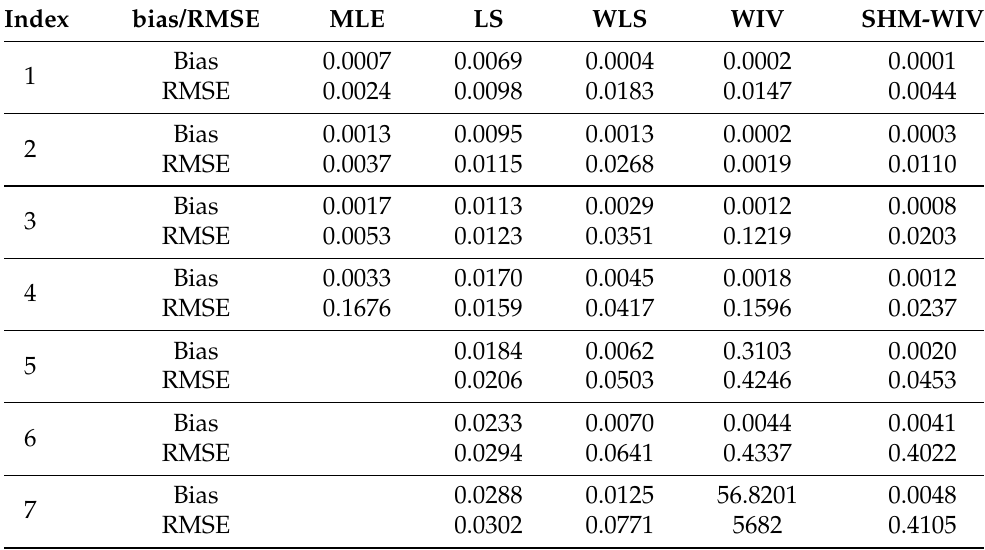
Table 3. Standard deviations of Monte Carlo results for bias/RMSE values.